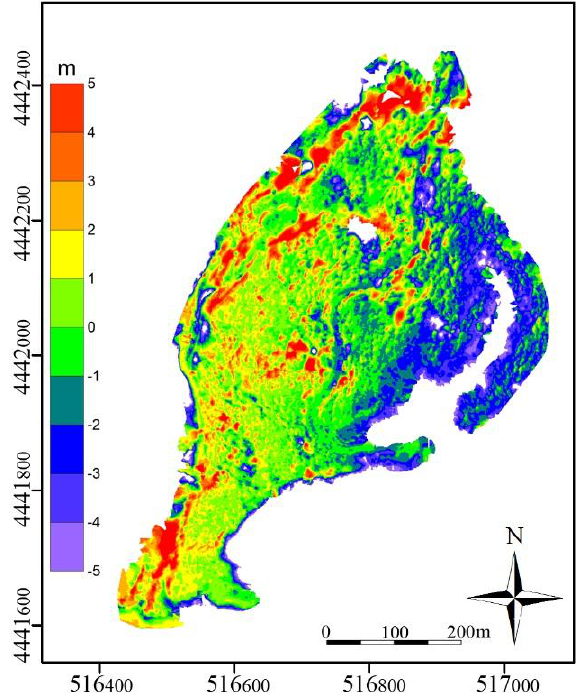
Figure 11. Height difference map obtained by subtracting the HRSI DEM grid from the TLS one.